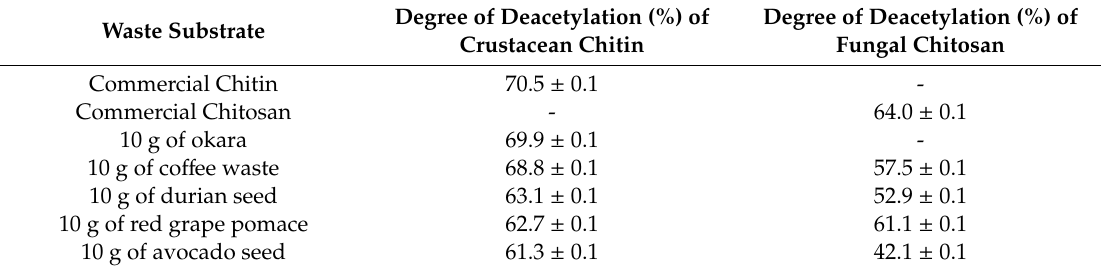
Table 3. Degree of deacetylation of crustacean chitin and fungal chitosan extracted after fermentation on various waste